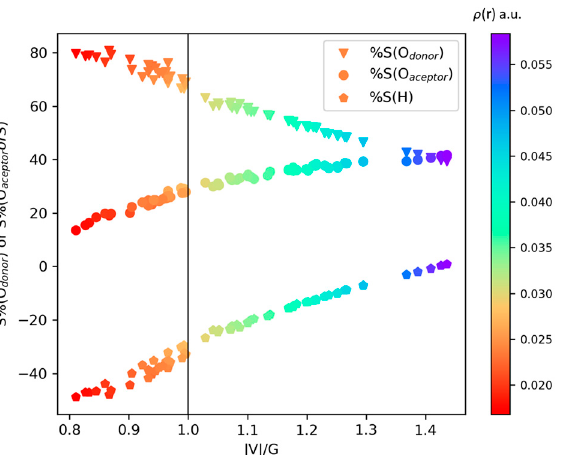
Figure 7. Relationship between atomic SF contributions to the HB ρ ( r BCP ) (a.u.) with the ratio | V ( r ) | / G ( r ) (a.u.). The color scale is related to the HB ρ ( r ) (a.u).